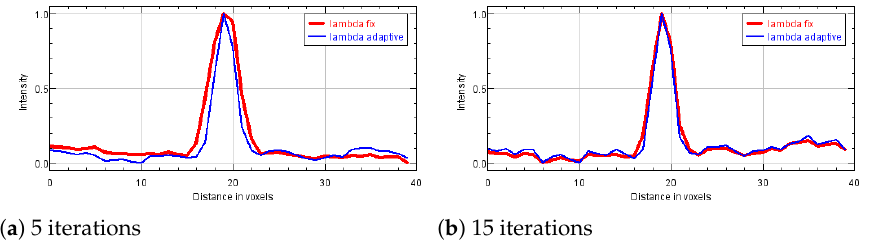
Figure 11. Plane Profiles on one microcalcification of cluster number 3 of the phantom, obtained with SGP with different regularization parameters, in 5 and 15 iterations. In all the plots the red line corresponds to fix parameter and the blue line to the adaptive choice of λ